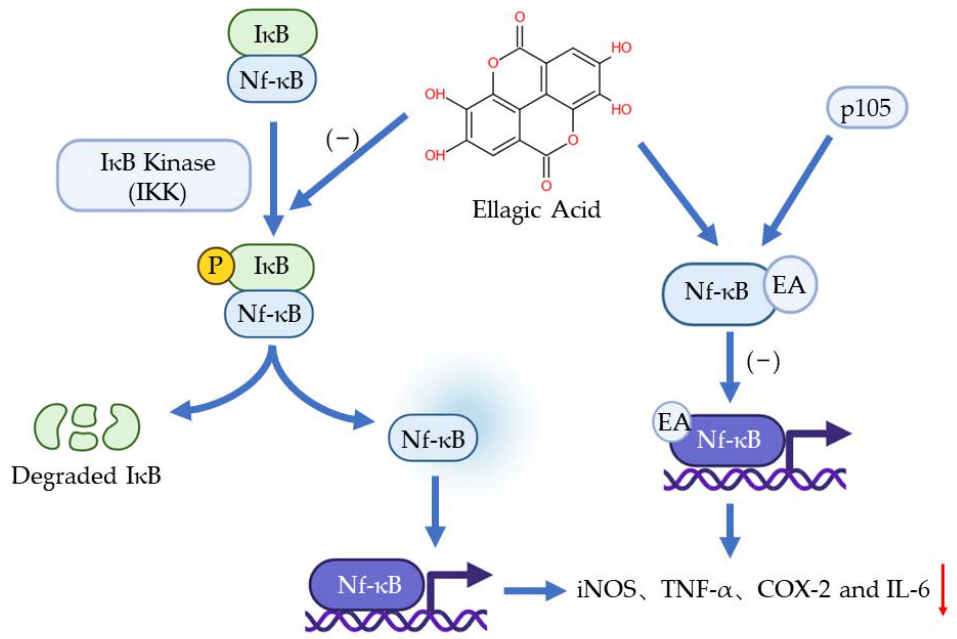
Figure 3. The anti-inflammation effects of EA to Nf- κ B Figure 3. The anti ‐ inflammation effects of EA to Nf ‐κ B pathway.